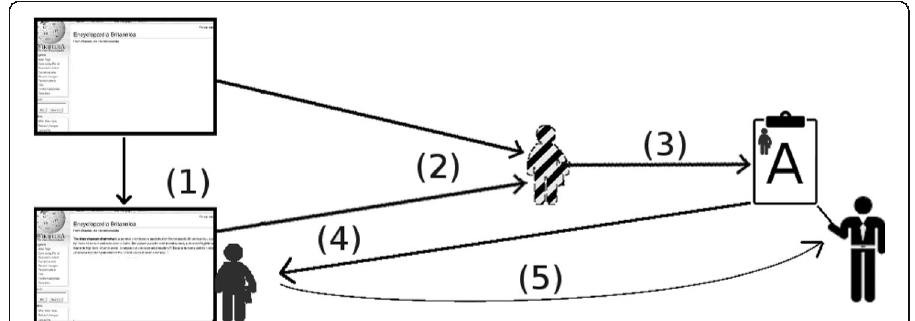
Fig. 4 Assessment stage